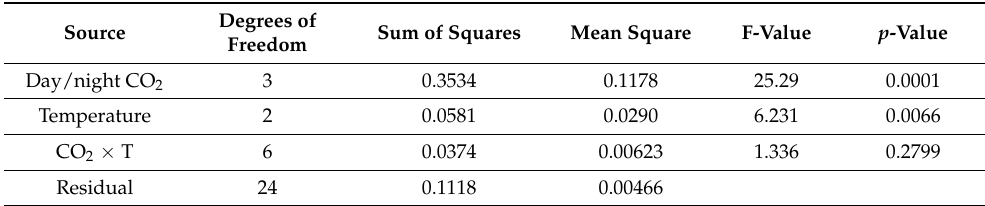
Table A5. Analysis of variance for turgor pressure of bean leaves under four day/night CO 2 condi- tions, at three growth